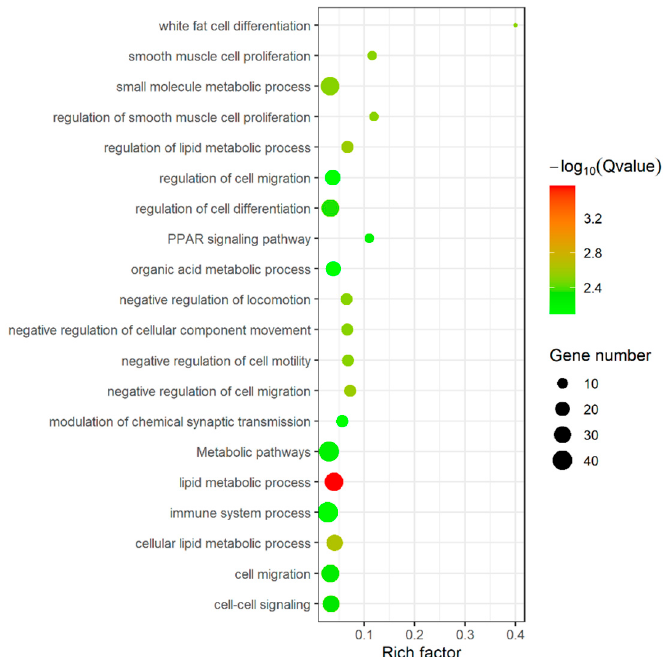
Figure 3. Functional analysis of DEGs: the most enriched top 20 Go terms and KEGG pathways of DEGs.